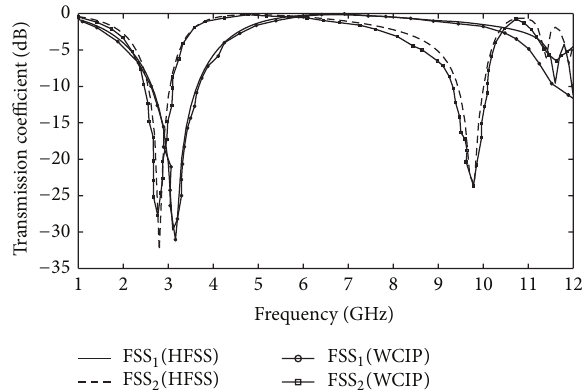
Figure 5: Simulated results for the transmission coefficient for FSS with cross fractal patch elements shown in Figure